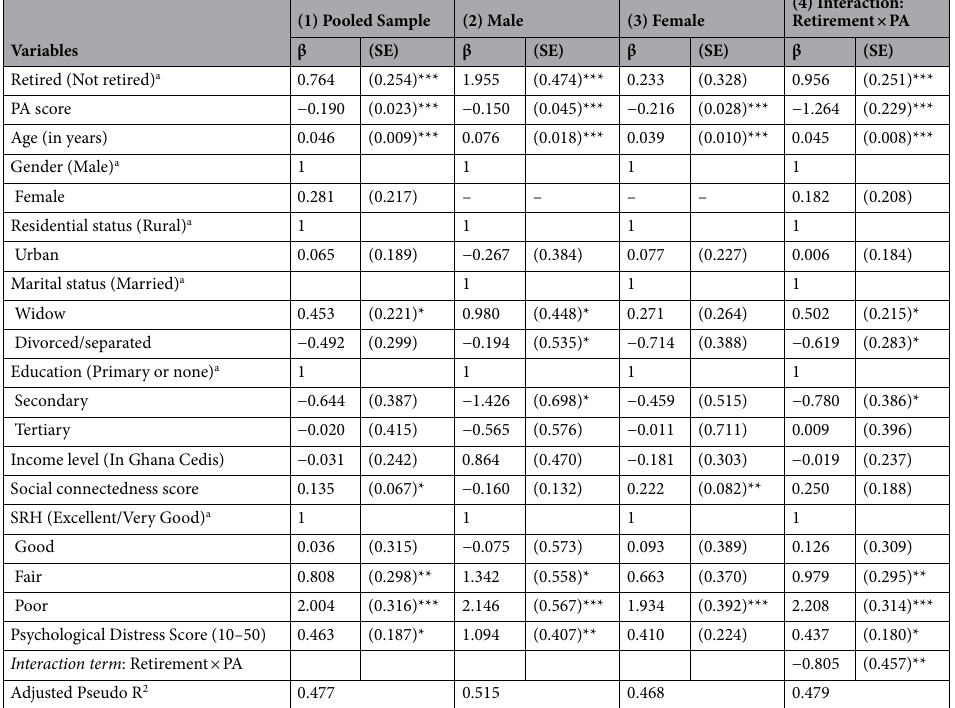
Table 4. Predicting FI Score with Retirement and PA Score: OLS Regression Models. β—Coefficients; SE— robust standard errors are presented in parentheses; SRH–Self-rated Health; a Reference Group. *** p < 0.001; ** p < 0.005; * p <